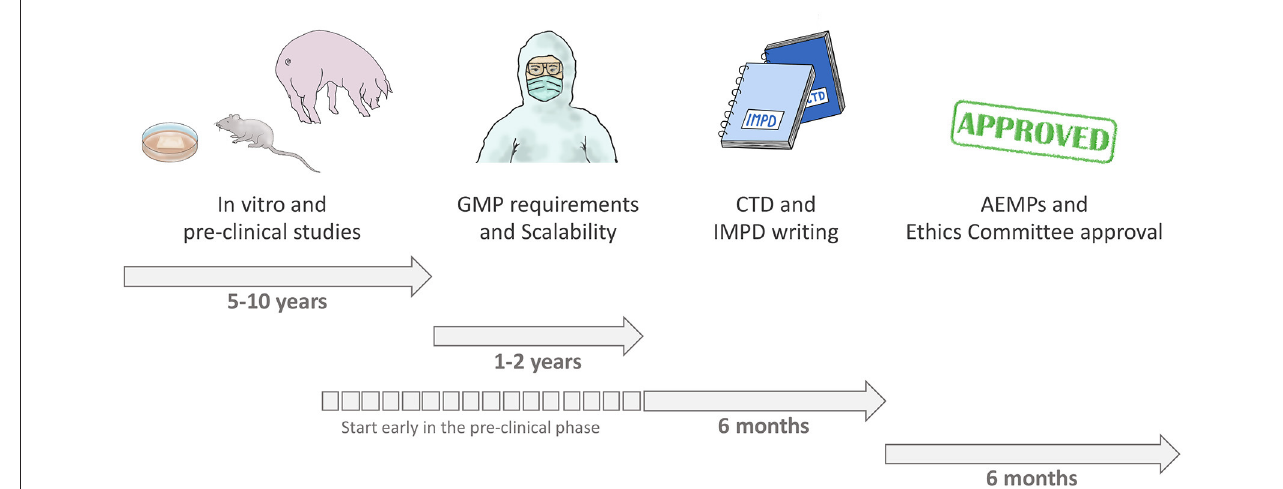
FIGURE 5 | Process of clinical